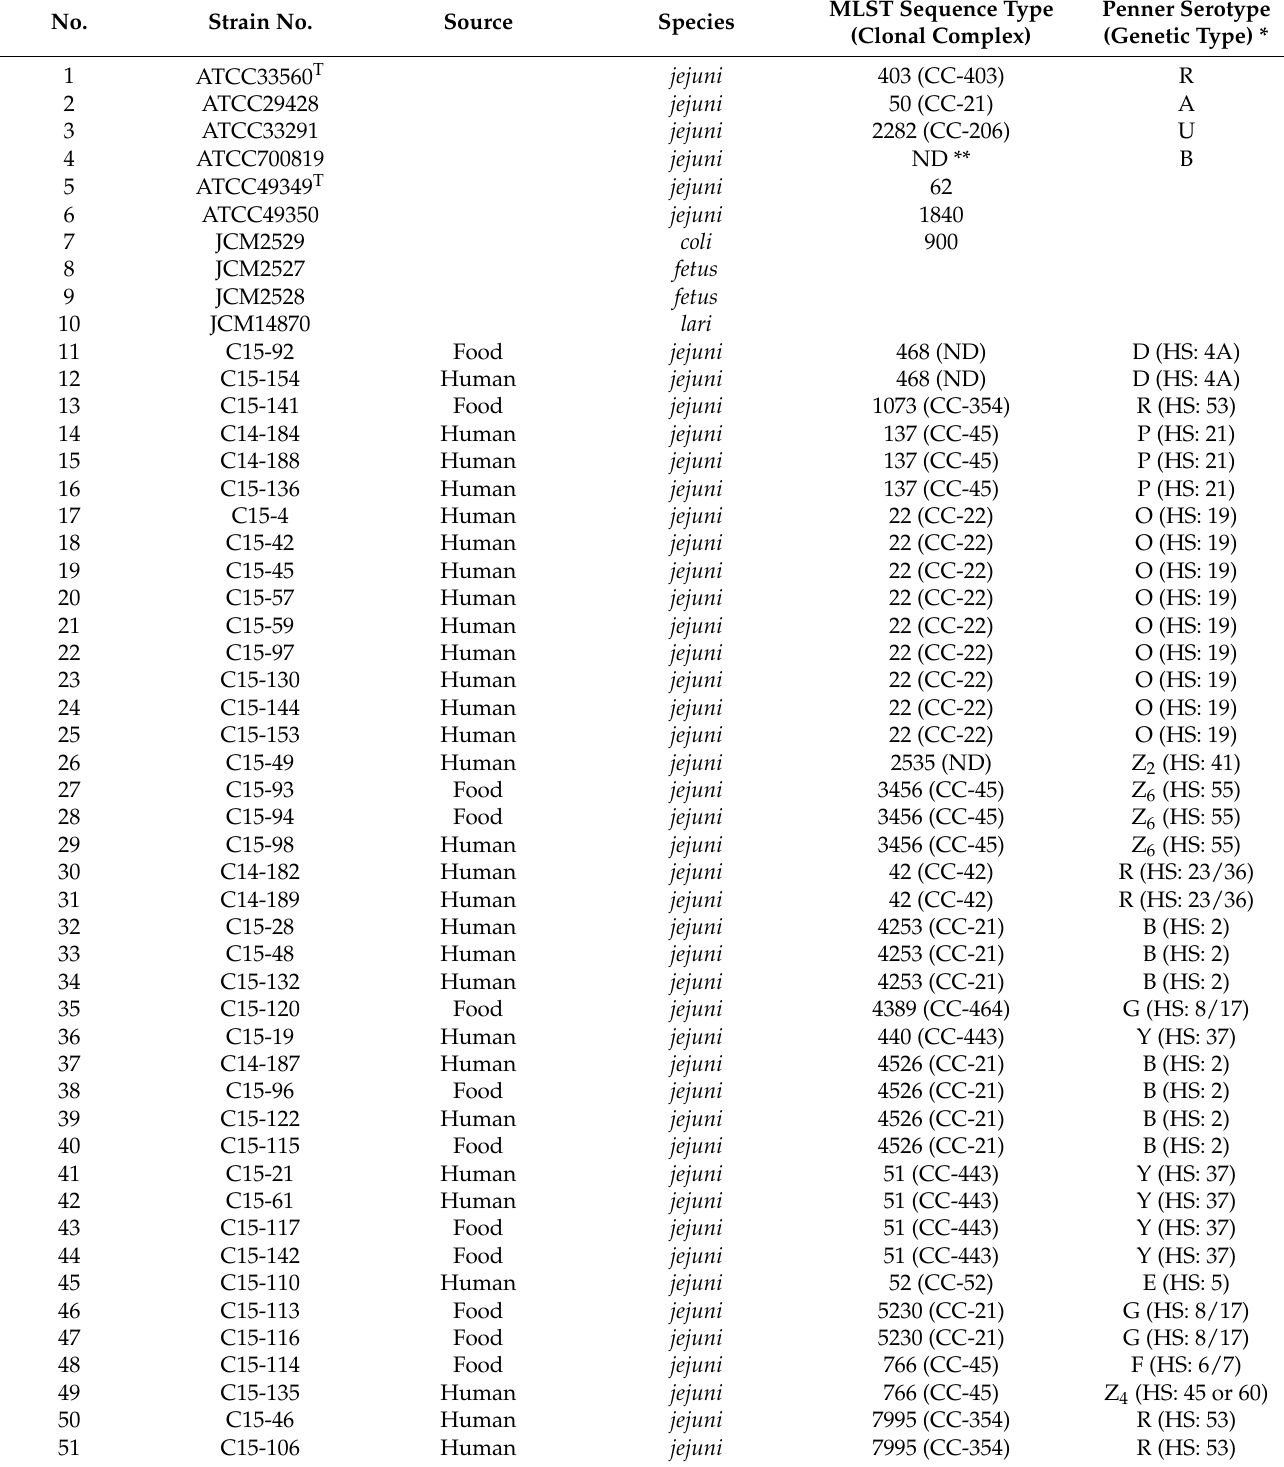
Table 1. Campylobacter spp. strains used in this